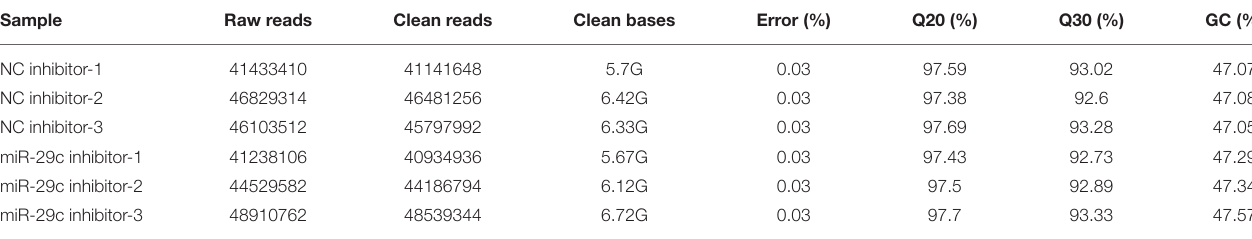
TABLE 1 | Summary of RNA-seq data.